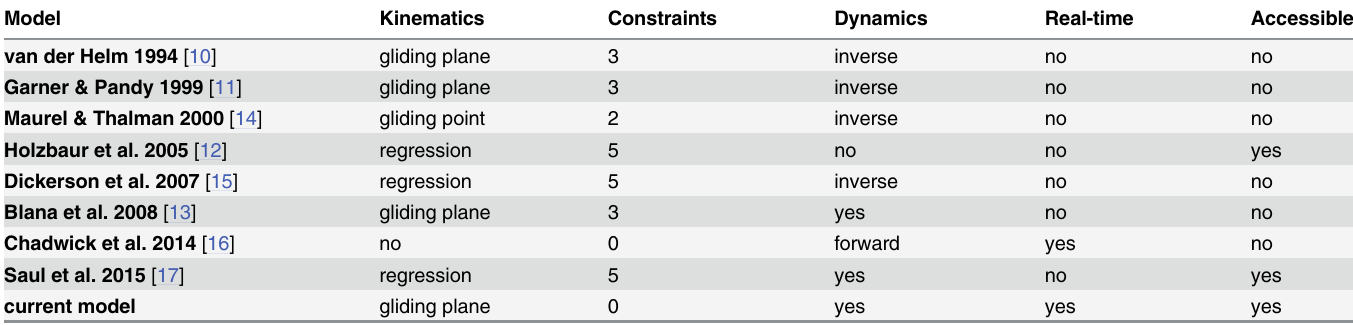
Table 1. Summary of models with scapula mechanics. Published models are listed with their modeling approach along with their suitability for real-time analyses and their accessibility for modification and re-use by other researchers and clinicians.